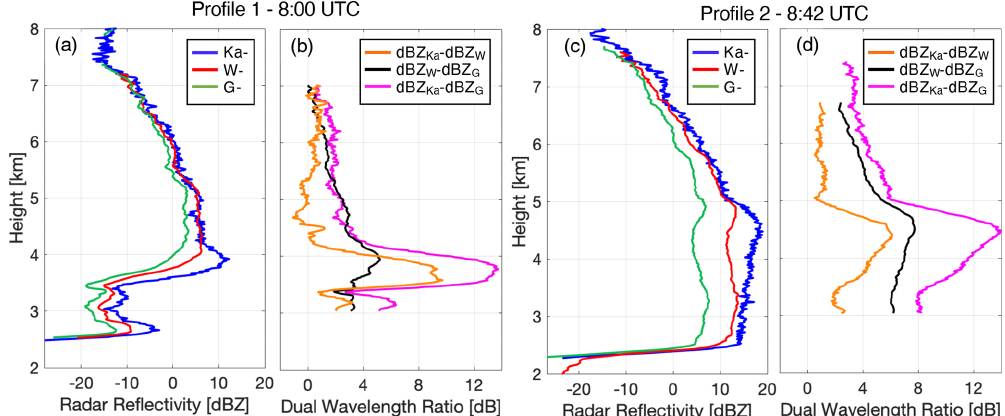
Figure 6. Profiles taken at 08:00UTC during the ice cloud period, (a) radar reflectivity measured by VIPR (G-band, green), ROGER (W- band, red) and KASPR (Ka-band, blue) and (b) associated dual-wavelength ratio from the Ka–W pair (orange), the W–G pair (black) and the Ka–G pair (magenta). Panels (c) and (d) show the same information for the profile taken at 08:42UTC.